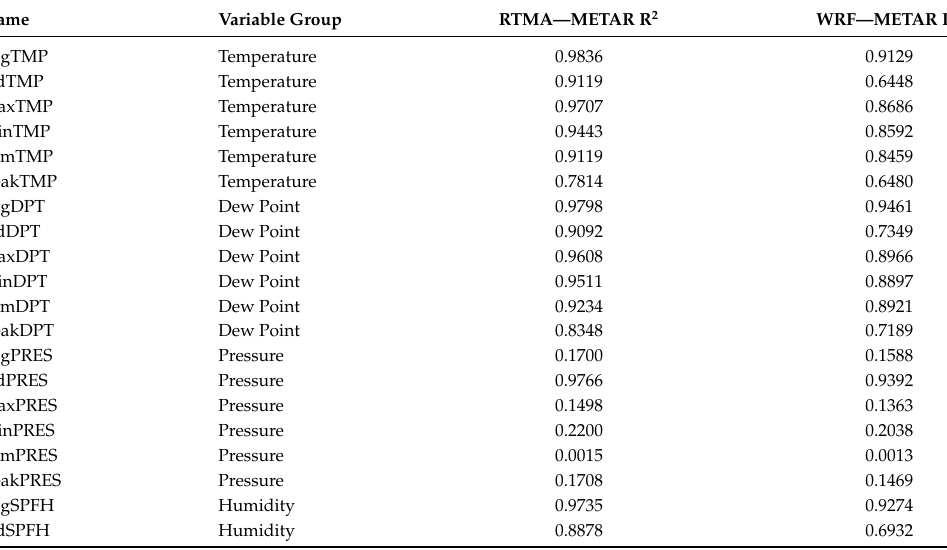
Table A2. Correlation between RTMA and WRF weather datasets, and METAR and SPECI